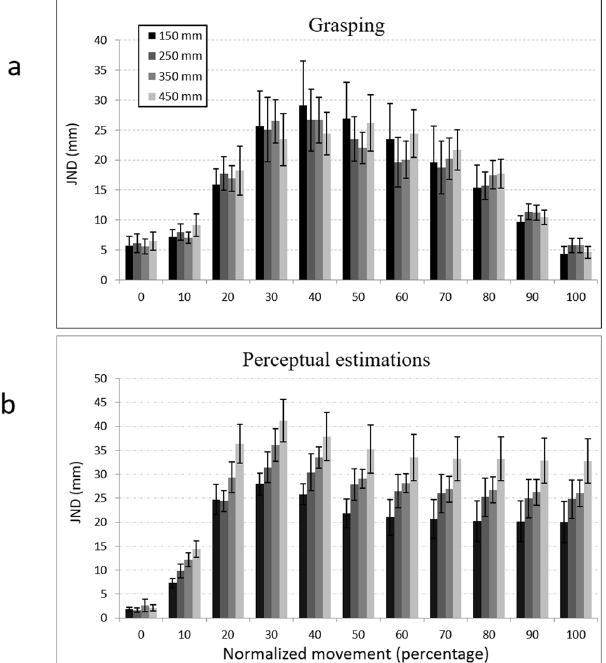
Figure 3. JNDs at different stages of the normalized movement during grasping ( a ) and during perceptual estimations ( b ). Perceptual estimations adhered to Weber’s law throughout the entire movement trajectory. In sharp contrast, grasping trajectories were immune to Weber’s law throughout the entire movement trajectory. Error bars represent standard errors of the mean.